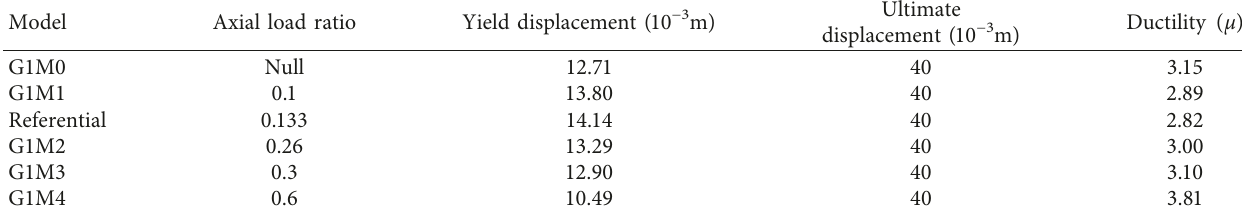
Table 8: Yield and ultimate displacement for ductility